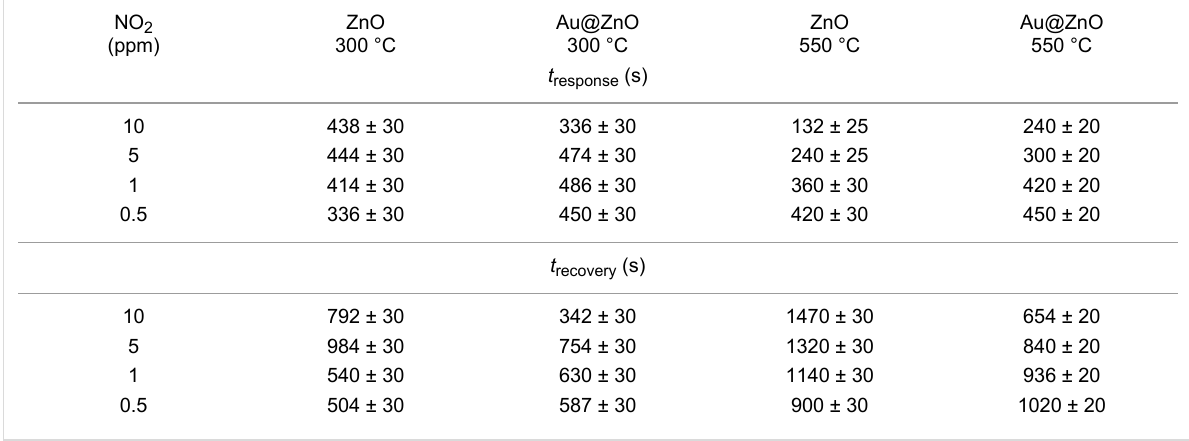
Table 2: Comparison of the response time ( t response ) and recovery time ( t recovery ) between spherical and rod-like pristine and Au-doped ZnO at various NO 2